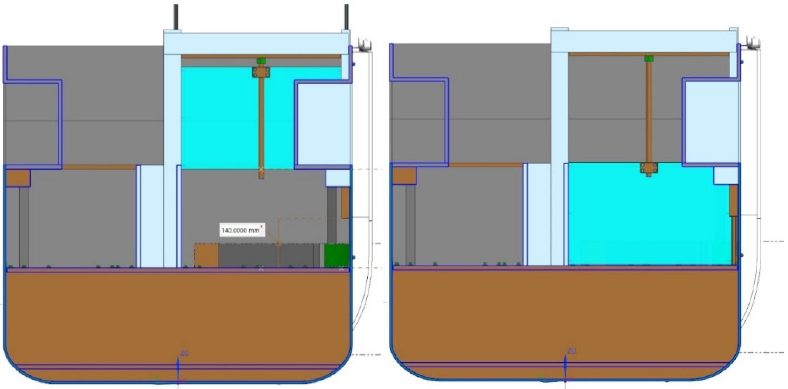
Figure A6. The deployable watertight barrier, shown with blue color: Left figure: high position, free water flow on the trailer deck. Right figure: the deployed barrier forms a watertight bulkhead on the trailer deck.